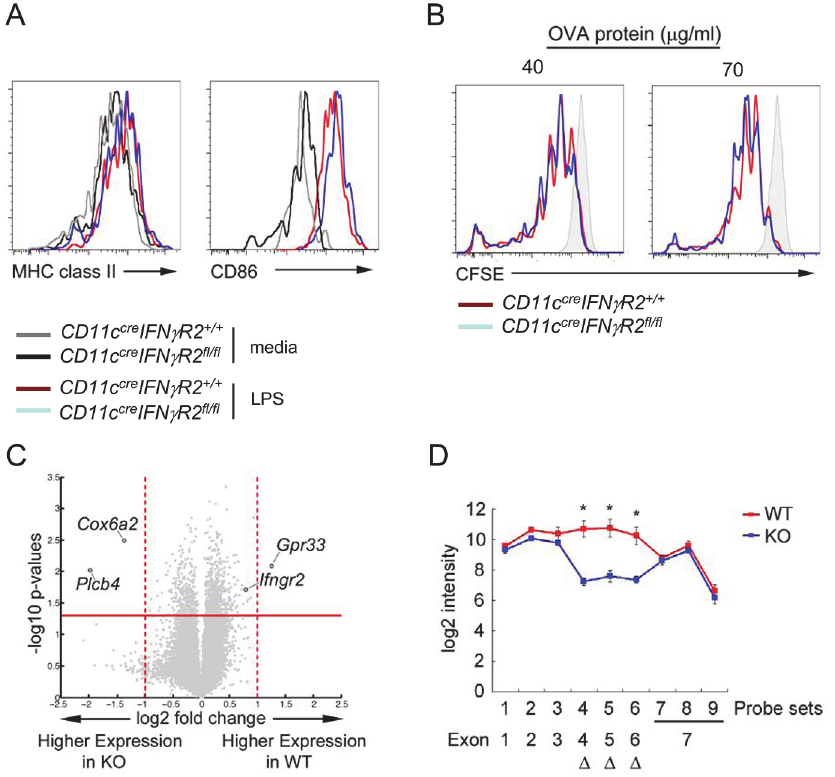
Fig 3. Dispensable role of IFN γ R in DC maturation and function at steady state. FACS analysis of MHC class II and CD86 in (A) CD11c + DCs with or without LPS stimulation for 24hr from CD11c cre IFN γ R2 fl/f and WT control mice. (B) Proliferation of OTII T cells co-cultured with DCs isolated from indicated mice pulsed with different does of OVA protein was shown by CFSE dilution. (C) Gene expression volcano plot, with — log 10 of the p value on the y axis and log 2 fold change on the x axis, such that genes with higher expression in WT DCs are on the right and genes with higher expression in KO DCs are on the left. (D) Signals (log2 intensity) of individual probe sets of Ifngr2 gene and their locations on corresponding exons. All data are representative of three independent experiments. ( * p <